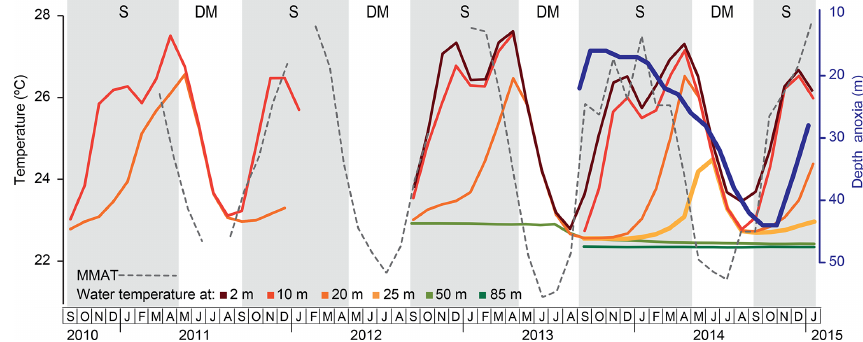
Figure 3. Temperature ( ◦ C) variation within the water column of Lake Chala between September 2010 and January 2015, based on automatic loggers suspended at 2, 10, 20, 25, 50 and 80m depth (as available), in relation to the Bodé et al. (2020) time series of mean monthly air temperature (MMAT; stippled line) at a savanna site ∼ 25km west of Lake Chala. The dark blue line shows the position of the oxycline be- tween September 2013 and December 2015, based on the shallowest depth with dissolved oxygen concentration < 0 . 2mgL − 1 , as measured by monthly water column profiling (van Bree et al., 2018). Grey shading highlights the seasonal periods of upper water column stratification (S) and deep mixing (DM). Due to the hiatus in temperature logging data, timing of the start and end of the deep-mixing period in 2012 was inferred from the MMAT